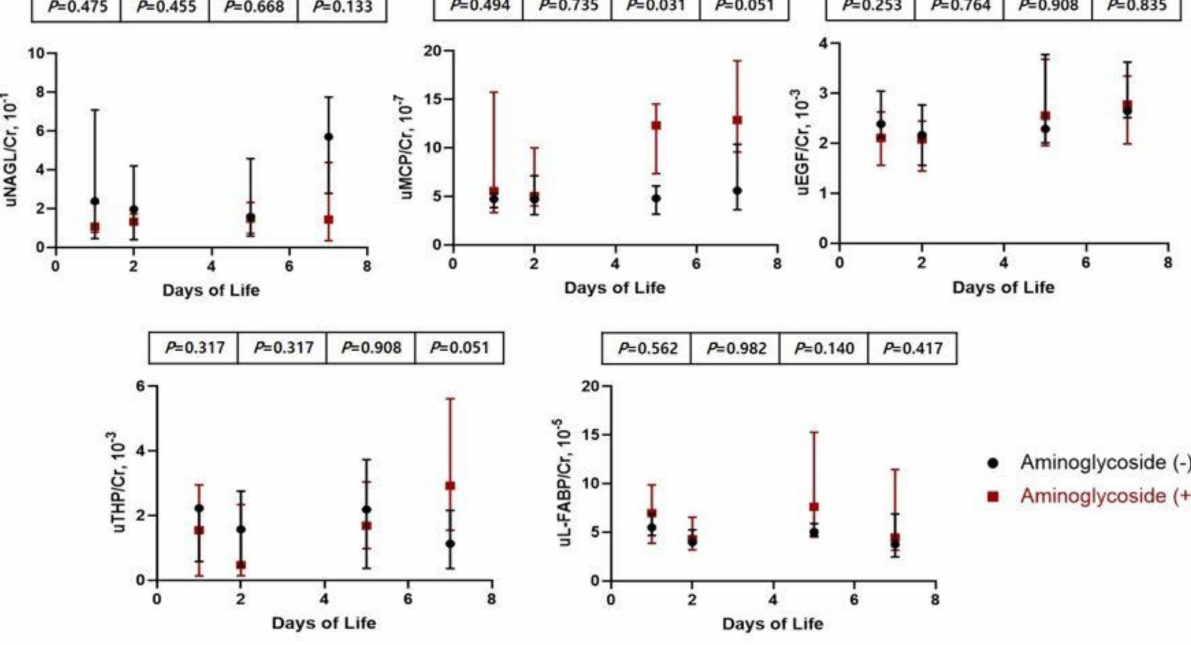
Figure 3. Comparison and changes in urinary biomarkers between infants with and without aminoglycoside